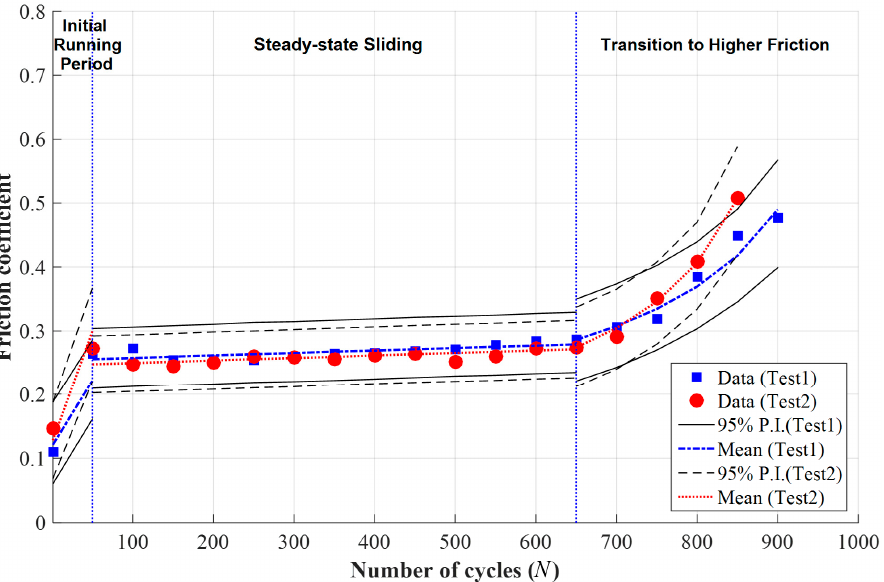
Figure 7. Estimated median and 95% predictive intervals (P.I.) based on the measured data at a normal force of 50 N, a displacement of 1 mm, and a frequency of 1 Hz.